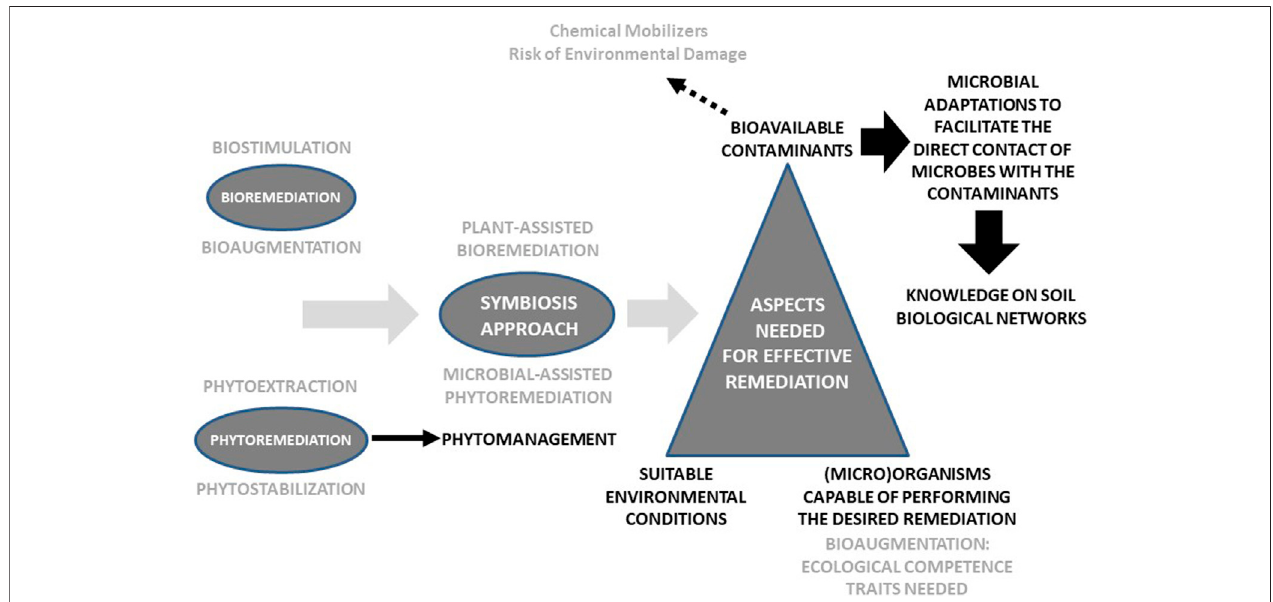
FIGURE 1 | Visual representation of the